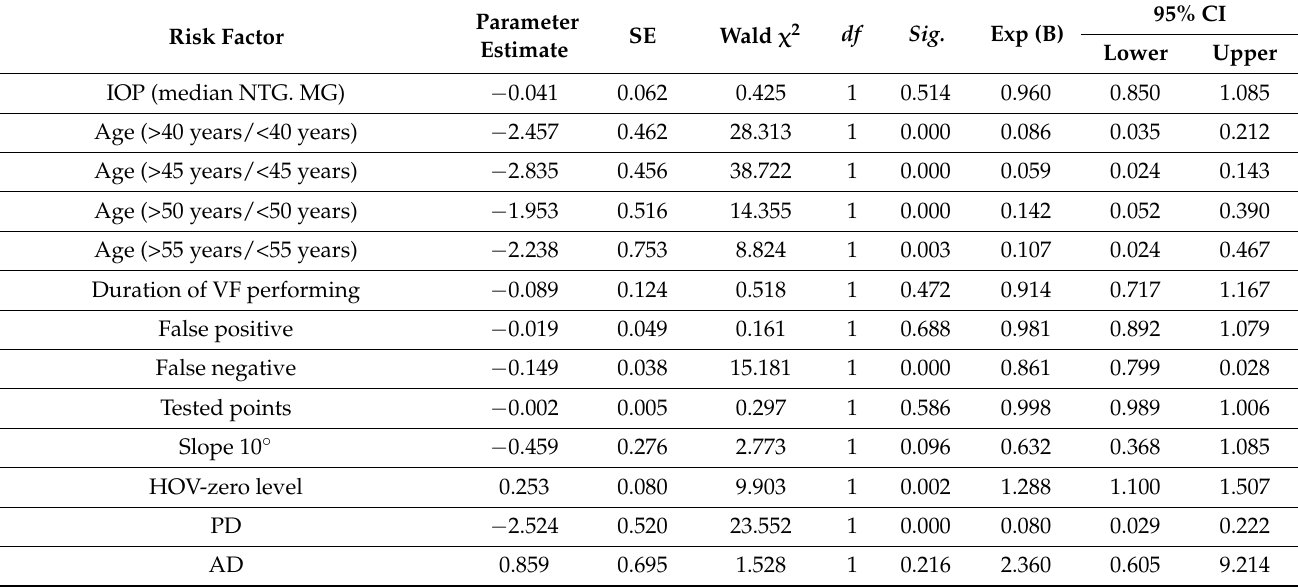
Table 9. Distribution of binomial logistic analysis results for NTG and NG patients at the first consultation.